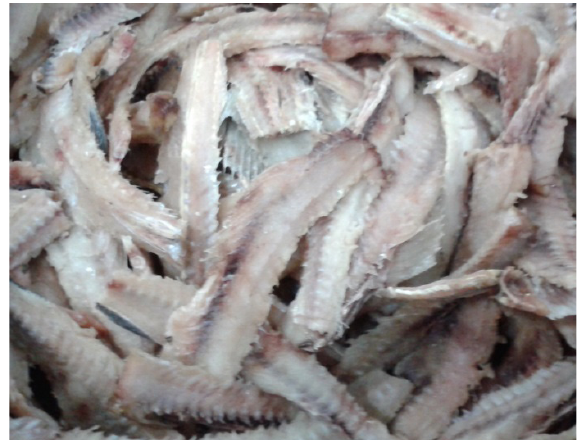
Figure 1: Baltic cod backbones devoid of heads and fins (raw material for processing).